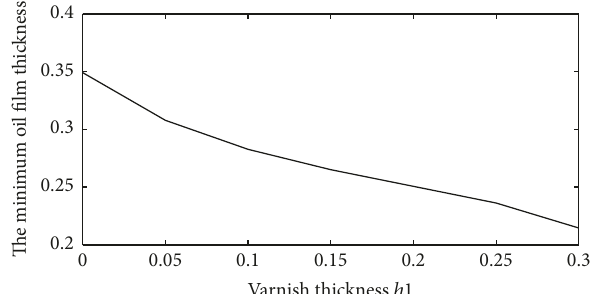
Figure 6: Variation of the minimum oil film thickness with varnish